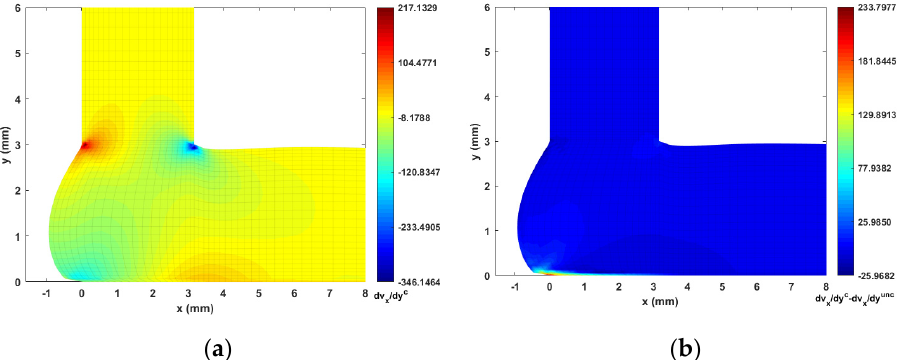
Figure 15. Velocity gradient contour dv x / dy near extrusion-deposition transition region: ( a ) fully coupled solution; ( b ) difference between the fully coupled and uncoupled